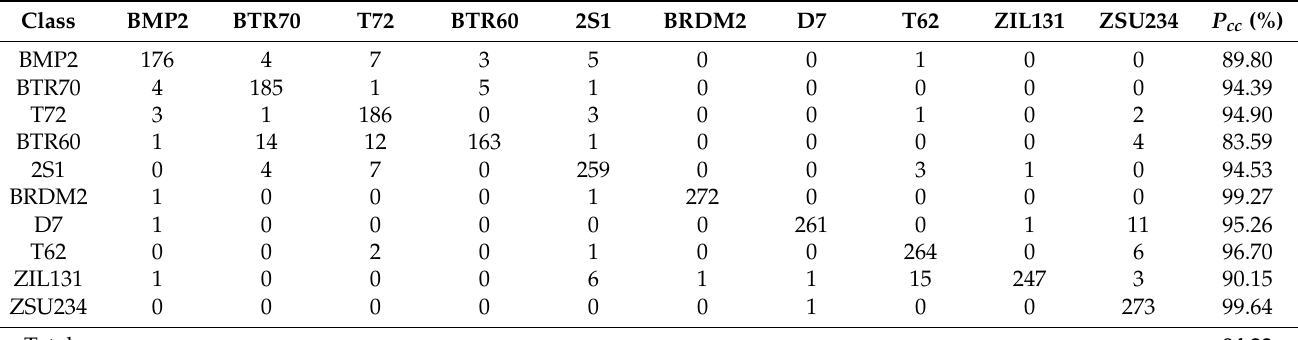
Table 4. Confusion matrix of the recognition result from the SE network related to Table 2.